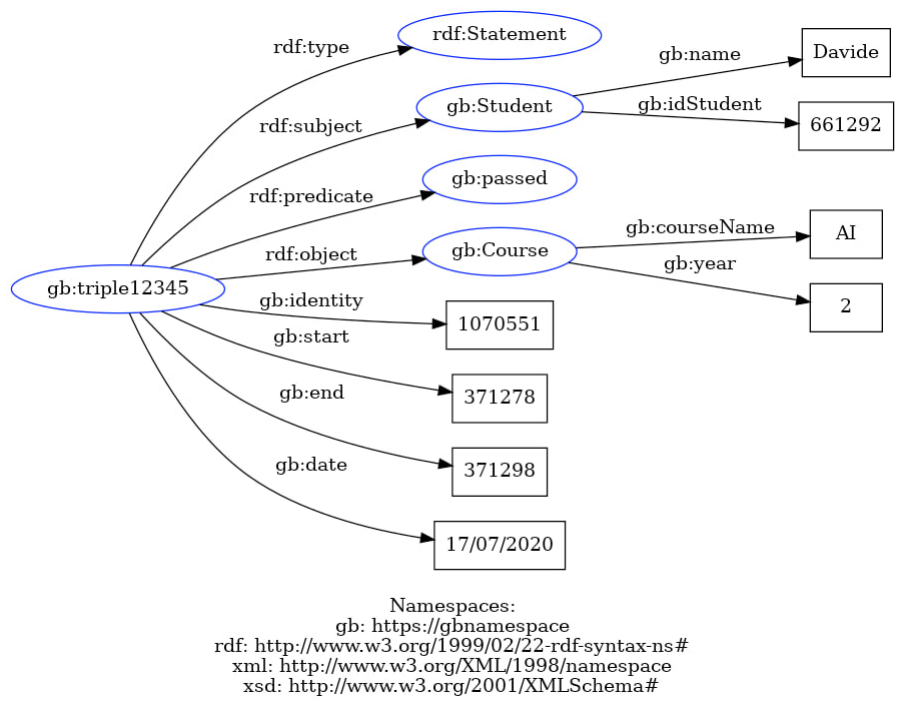
Figure 2. RDF representation after mapping. As you can see, the “passed” relationship is now reified as a